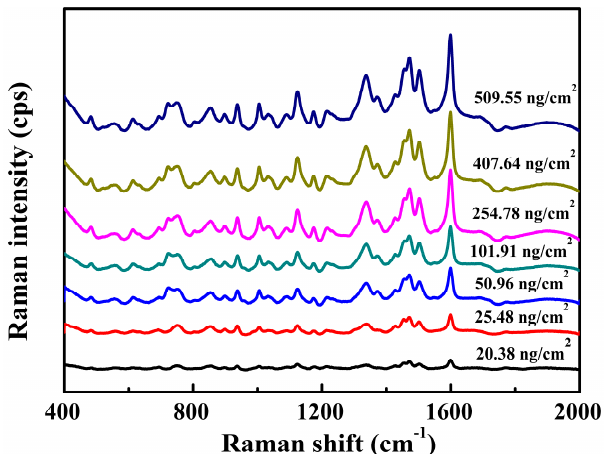
Figure 6. Representative surface-enhanced Raman scattering (SERS) spectra of tartrazine extracts from large yellow croaker skin ( n = 30).